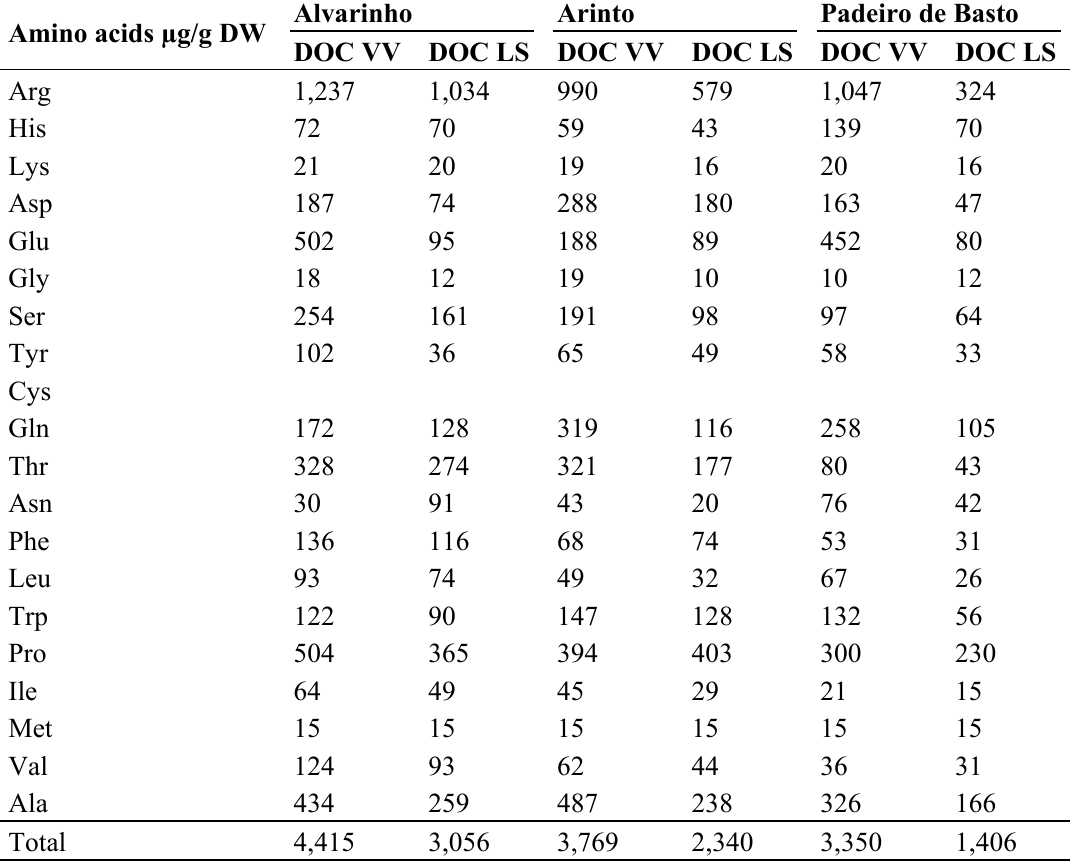
Table 1. Amino acid content in mature grape berries from Alvarinho, Arinto and Padeiro de Basto varieties cultivated in the DOC VV and DOC LS regions. Values are expressed as microgram per gram dry weight